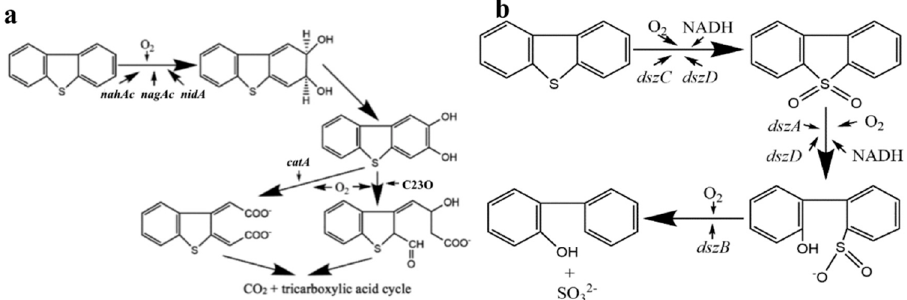
Figure 5. Functional genes for the degradation of DBT (dibenzothiophene) by the Kodama pathway and the 4S pathway. ( a ) Kodama pathway; ( b ) 4S pathway [56]. Permission obtained through Rights Link ® .